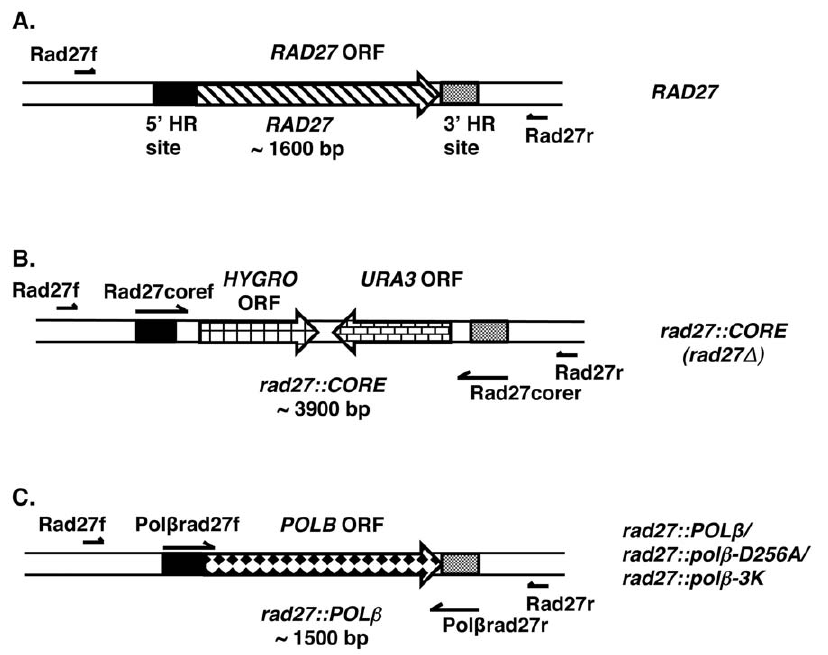
Figure 1. Strategy for introduction of a human DNA POL b open reading frame into the S. cerevisiae genome. (A) Schematic representation of the RAD27 gene ( , 1600 bp) of S. cerevisiae is shown. The positions of the RAD27 5 9 and 3 9 homologous recombination integration sites (5 9 and 3 9 HR sites, respectively), relative to the 5 9 and 3 9 regions of the Rad27 gene, are indicated. The positions of the forward primer (Rad27f) and the reverse primer (Rad27r) used for genotyping are also illustrated. (B) First, the CORE-I-SCEI was amplified using the Rad27coref and Rad27corer primers. The rad27 :: CORE strain was constructed by homologous recombination of a PCR product containing the CORE-I-SCEI cassette containing URA3 and hygromycin (HYGRO) markers flanked by up-and-downstream RAD27 sequence. Hygromycin-resistant transformants were genotyped using the Rad27f and Rad27r primers. Correct integration of the CORE cassette resulted in a PCR product of , 3900 bp. Failure to integrate resulted in wild-type product of , 1600 bp. (C) The strains of rad27 :: POL b , rad27 :: pol b -D256A, and rad27 :: pol b -3K were generated by homologous recombination of a PCR product of POLB open reading frame using primers Polbrad27f and Polbrad27r. Replacement of the CORE cassette by human POL b open reading frame was confirmed using primers Rad27f and Rad27r that resulted in a PCR product of , 1500